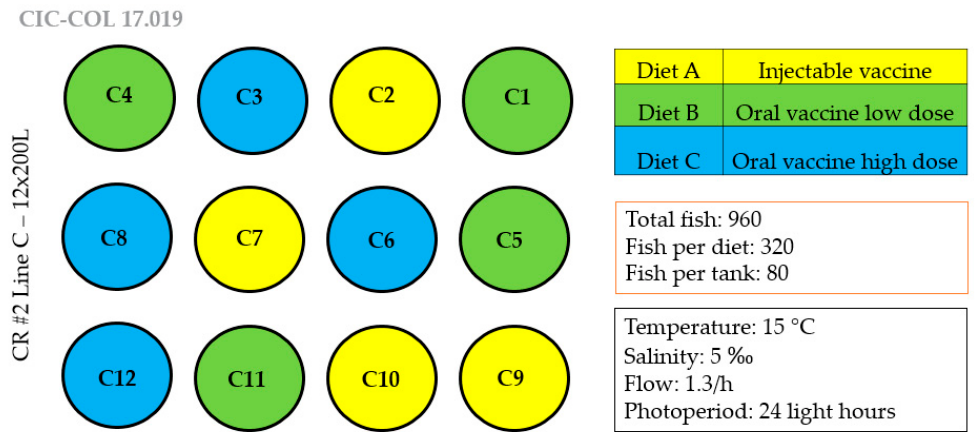
Figure 1. Experimental design for oral vaccine trial with alginate-encapsulated Piscirickettsia salmonis antigens infused in fish feed pellets. The experimental design included three fish groups (low dose, high dose, injectable vaccine) with four tanks per group and 80 fish per tank.